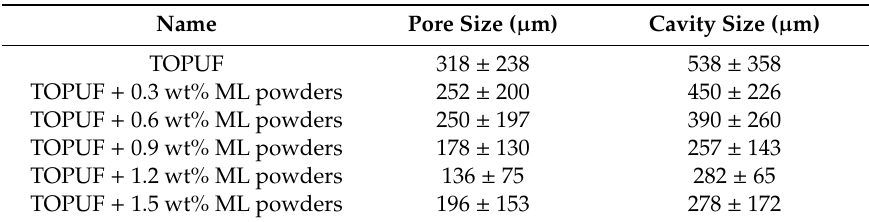
Figure 8. SEM images of TOPUF ( a ), TOPUF with 0.3 wt % ( b ), 0.6 wt % ( c ), 0.9 wt % ( d ), 1.2 wt % ( e ), and 1.5 wt % ( f ) ML powders. Table 4. Sizes of pores and cavities in di ff erent TOPUFs. Table 4. Sizes of pores and cavities in different TOPUFs.